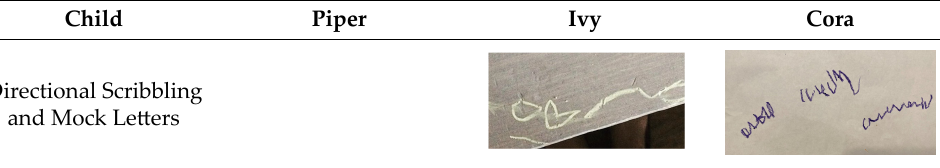
Table 1. The Pre-Alphabetic Stage. Table 1. The Pre‑Alphabetic Stage.